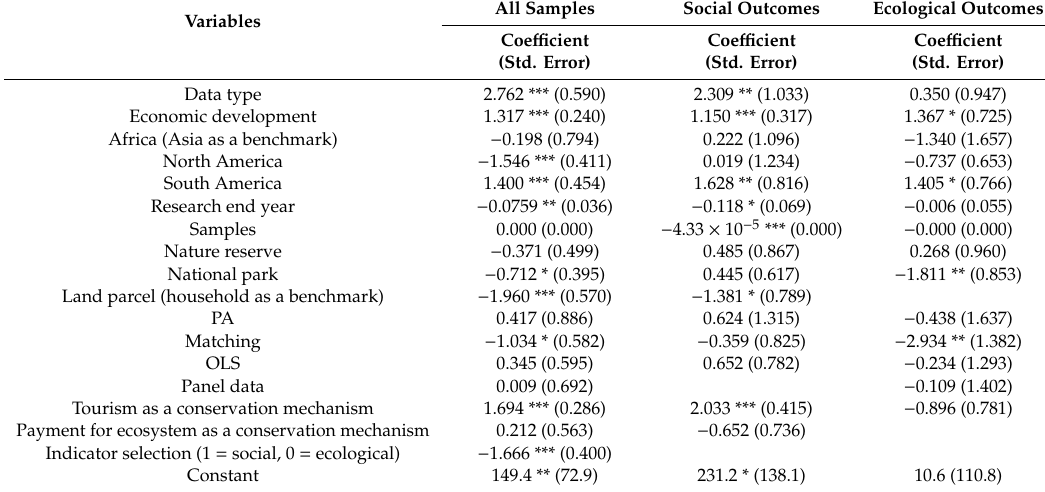
Table 3. Factors a ff ecting the evaluation outcomes of the establishment of protected areas to be significant and